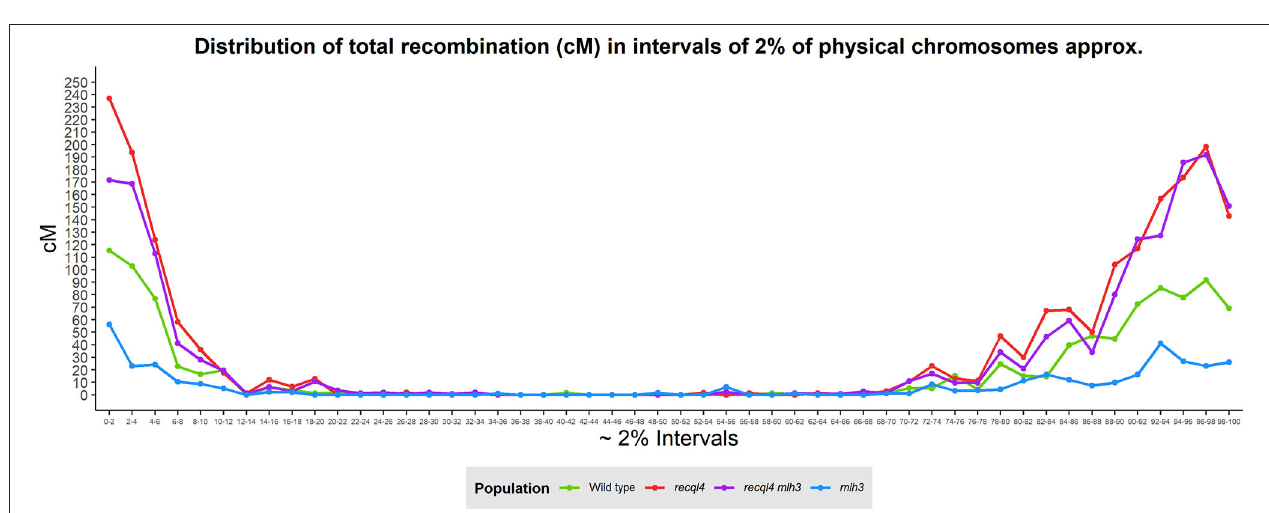
FIGURE 6 | Genome-wide distribution of recombination based on the division of the physical chromosomes in 2%